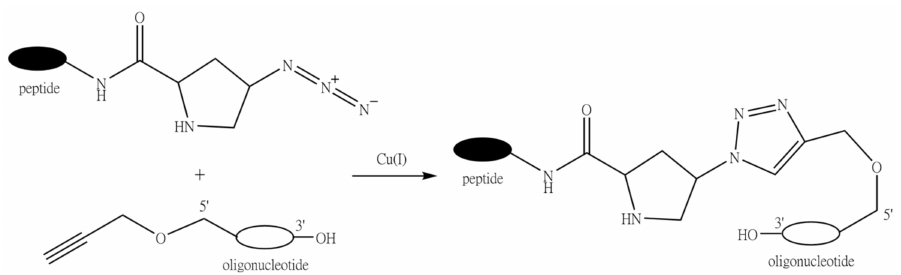
Figure 17. An example of peptide-oligonucleotide conjugation via the copper(I)-catalyzed 1,3-dipolar cycloaddition reaction of alkynes to azides